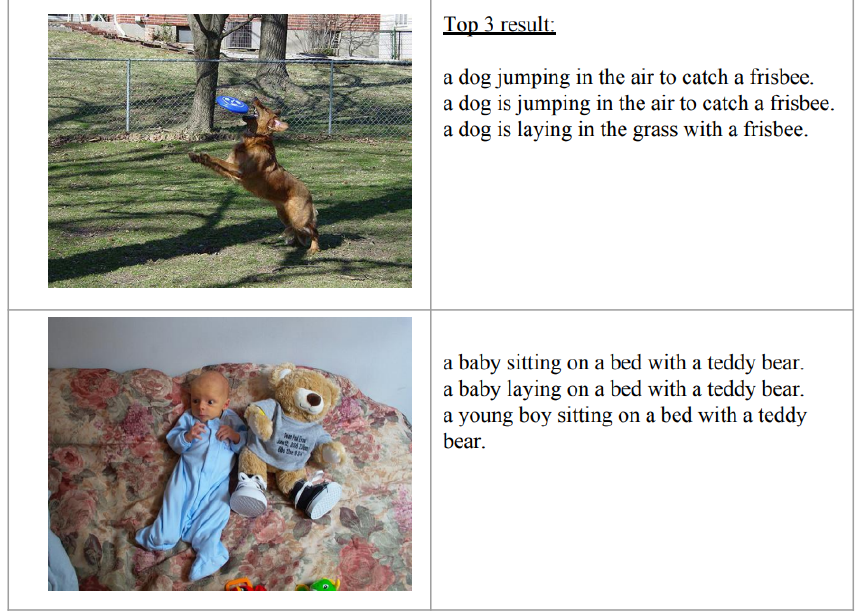
Figure 4. The top three sentences generated by the beam search algorithm.